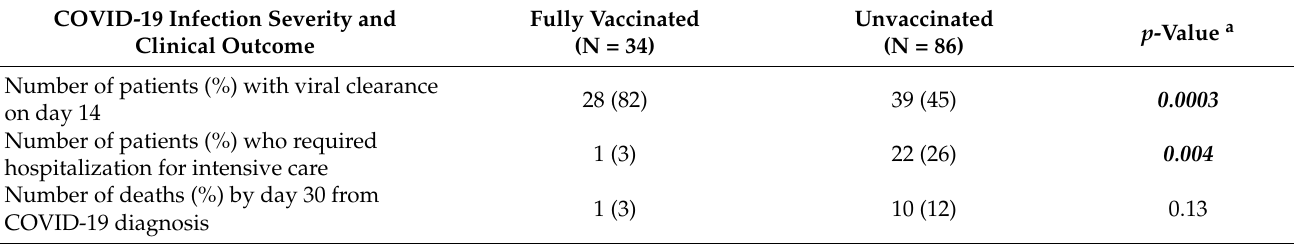
Table 2. Clinical outcomes of COVID-19 in hematological patients by baseline vaccination